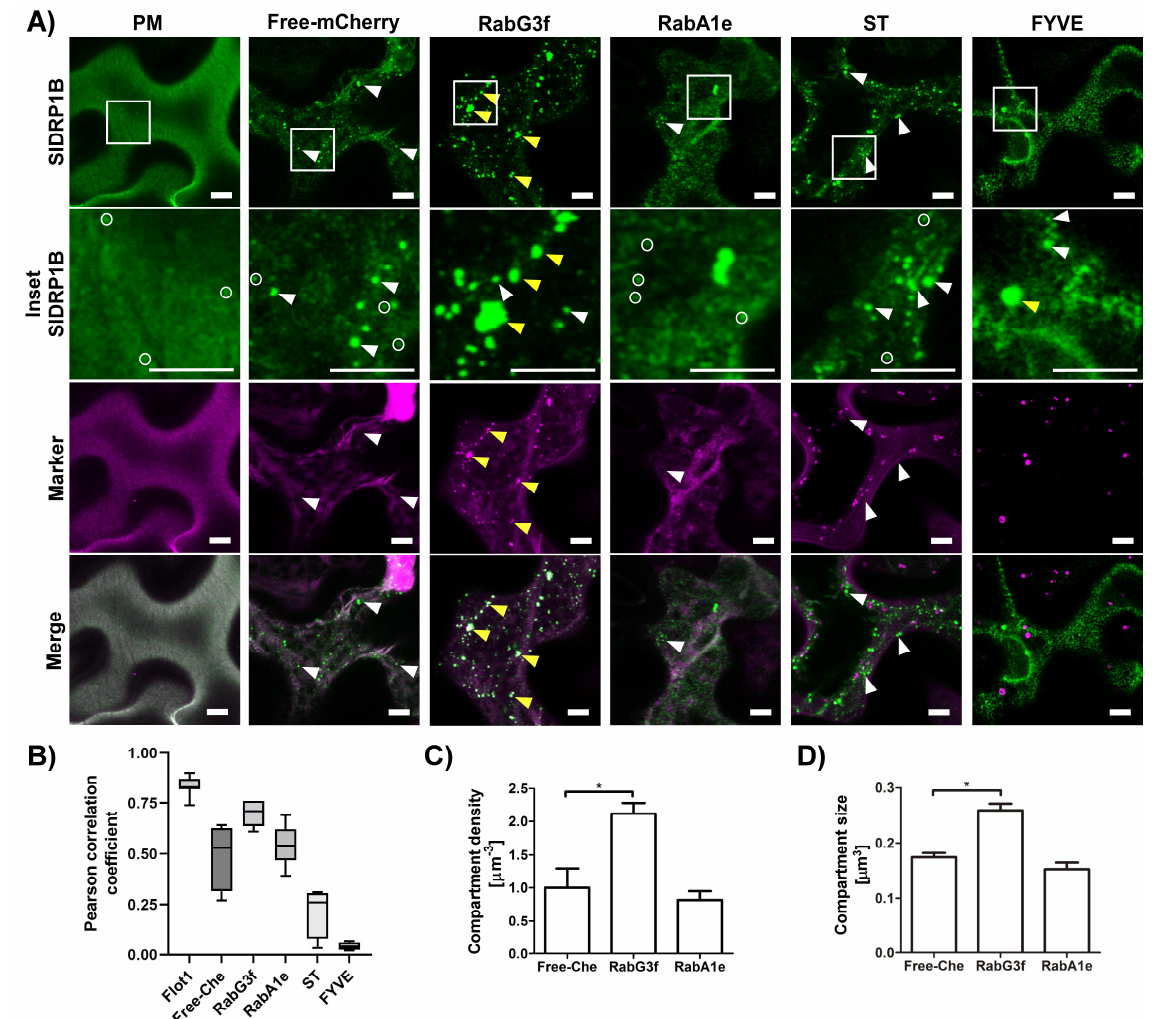
Figure 2. SlDRP1B localizes to a subset of MVB/LE/PVC compartments. Localization of SlDRP1B was analyzed by confocal microscopy of N. benthamiana epidermal cells transiently expressing SlDRP1B-GFP and different endomembrane compartment markers as indicated. Images were ac- quired using a Zeiss LSM 780 microscope. ( A ) Representative images of SlDRP1B-GFP colocalization with Flot1-mCherry, free mCherry, RabG3f-mCherry, RabA1e-mCherry, ST-mCherry, and FYVE-dsRED are shown. White and yellow arrowheads point to SlDRP1B compartments and SlDRP1B compartments colocalizing with the markers, respectively. Circles indicate SlDRP1B foci. Squares indicate the inset region. Scale bar 7.5 μm. ( B ) Colocalization analysis between SlDRP1B and the markers. ( C , D ) SlDRP1B endosomes density Endosome density was normalized to control (Free mCherry). Control = 0.013 endosomes per μm 2 . ( B – D ) Twelve images each were analyzed. ( C , D ). Error bars represent mean ± SEM. Asterisks indicate significant differences with free mCherry control ( t -test, * p < 0.05).